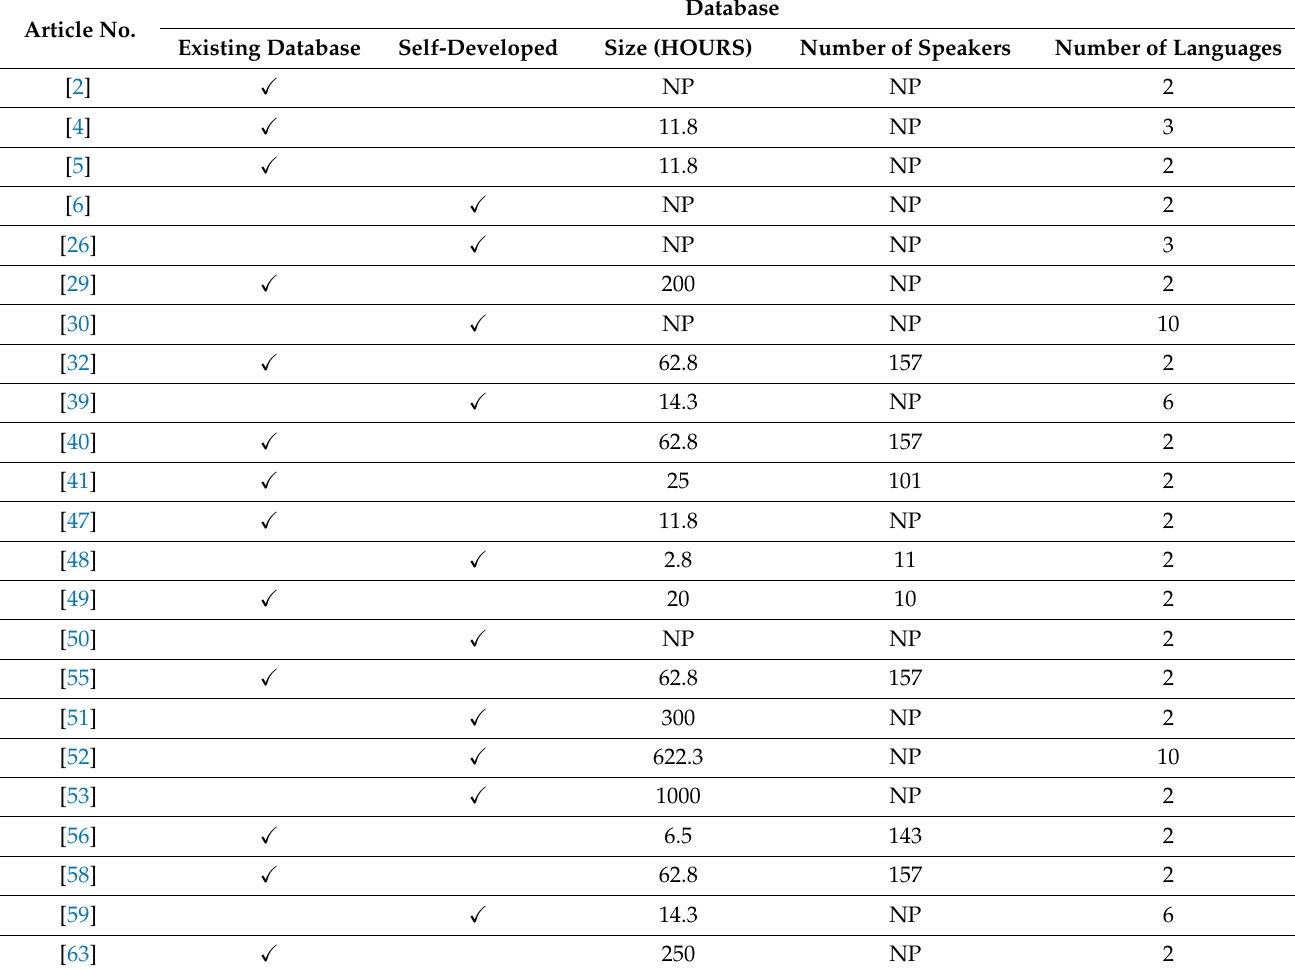
Table 2. The details of the CS databases used in the existing